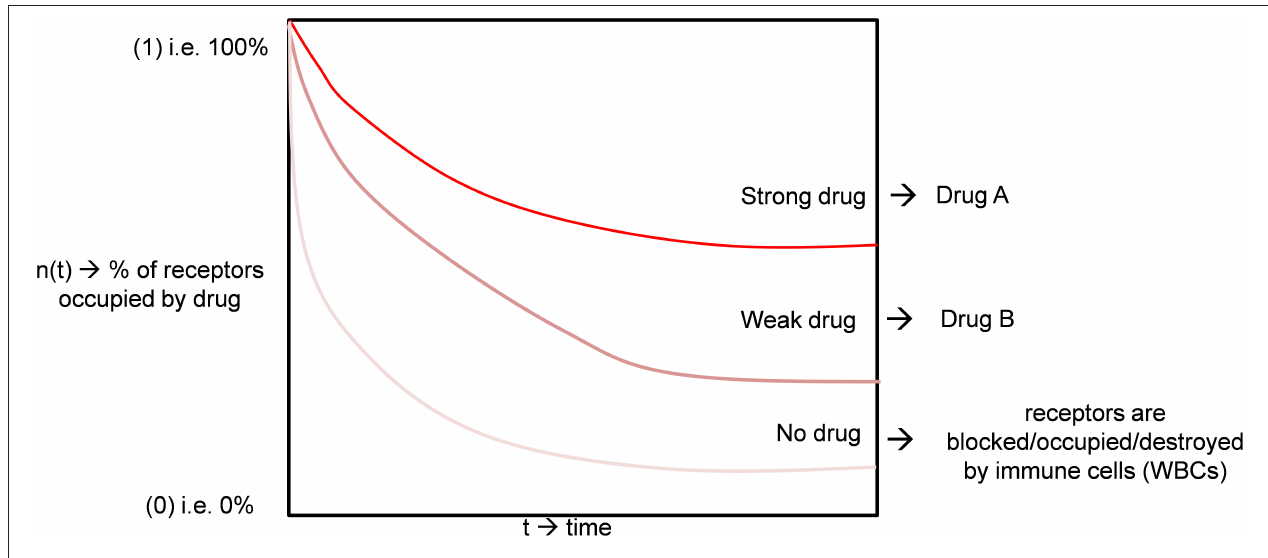
FIGURE 2 | The quantitative model of drug interaction with a viral receptor based on its potency.